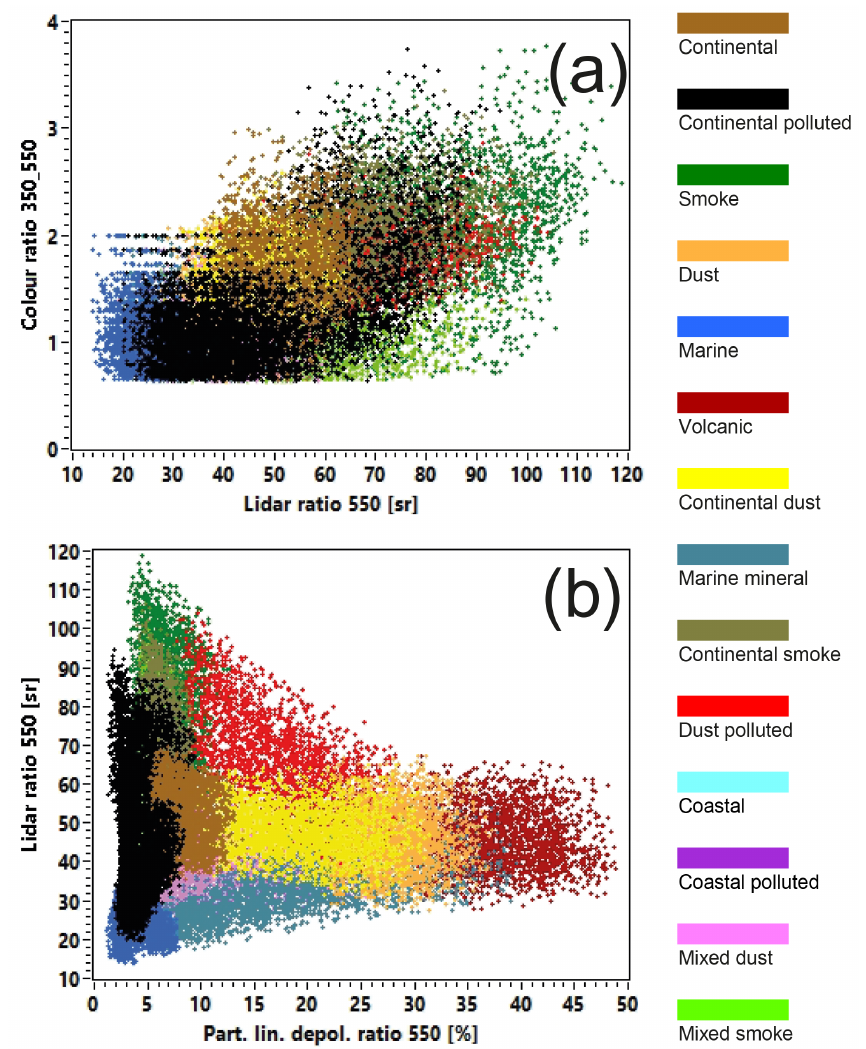
Figure 6. Synthetic data set with (a) colour ratio versus lidar ratio, and (b) lidar ratio versus linear particle depolarization ratio using the NATALI